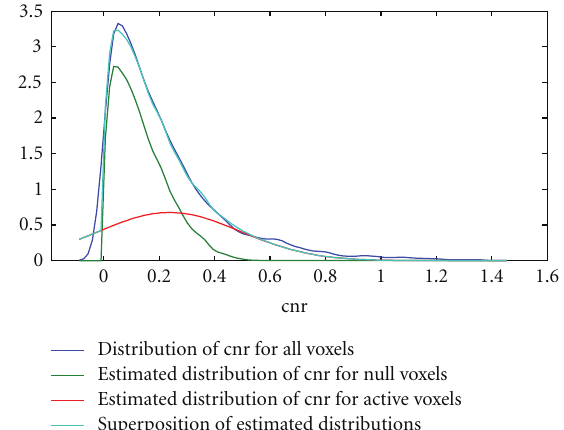
Figure 4: Density estimation of active and inactive voxels in motor activation data. The top curve (dark blue) shows the distribution of the cnr using kernel density estimation techniques. The green and red curves are the estimated distributions of the cnr for the inactive and active voxels, respectively. Note that the distribution of the inactive voxels (green curve) was derived from wavelet resampled resting-state data using a dilation variable, whereas the distribution of the active voxels (red curve) was derived from a Gaussian distribution. The mixture of the estimated distributions for null and active voxels is given by the light blue curve showing very small di ff erences to the raw curve (dark blue).